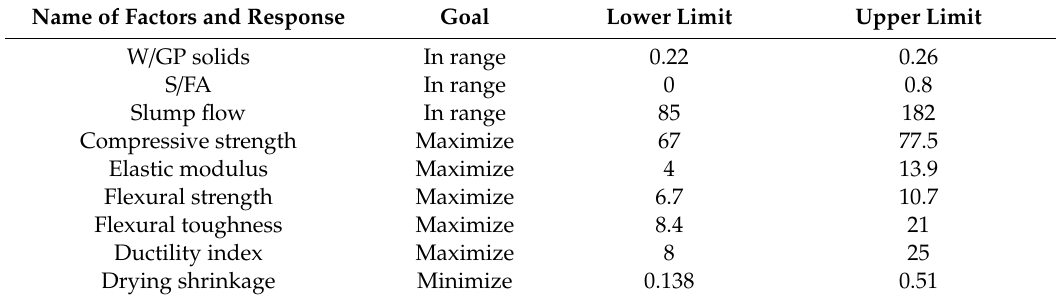
Table 10. Definitions of factors and responses in the multiobjective optimization problem.